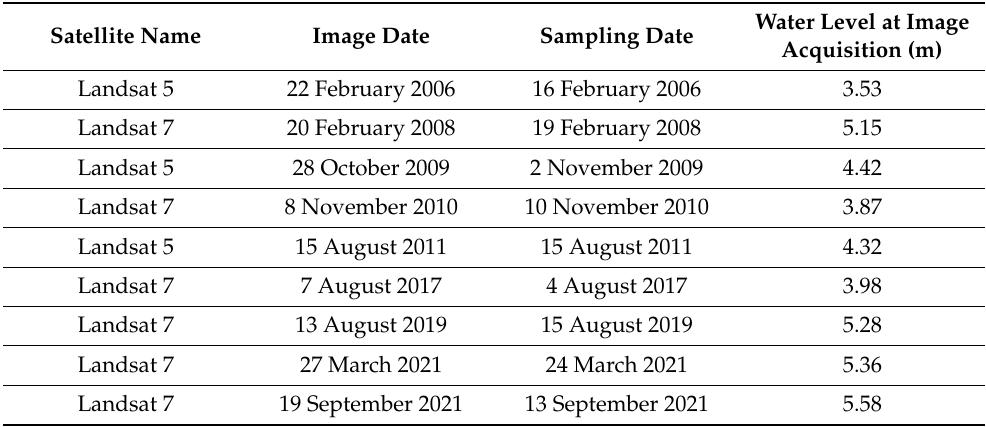
Table 4. Summary of Landsat images used in the validation of the regression model (zero water level = 3.36 m below the mean sea